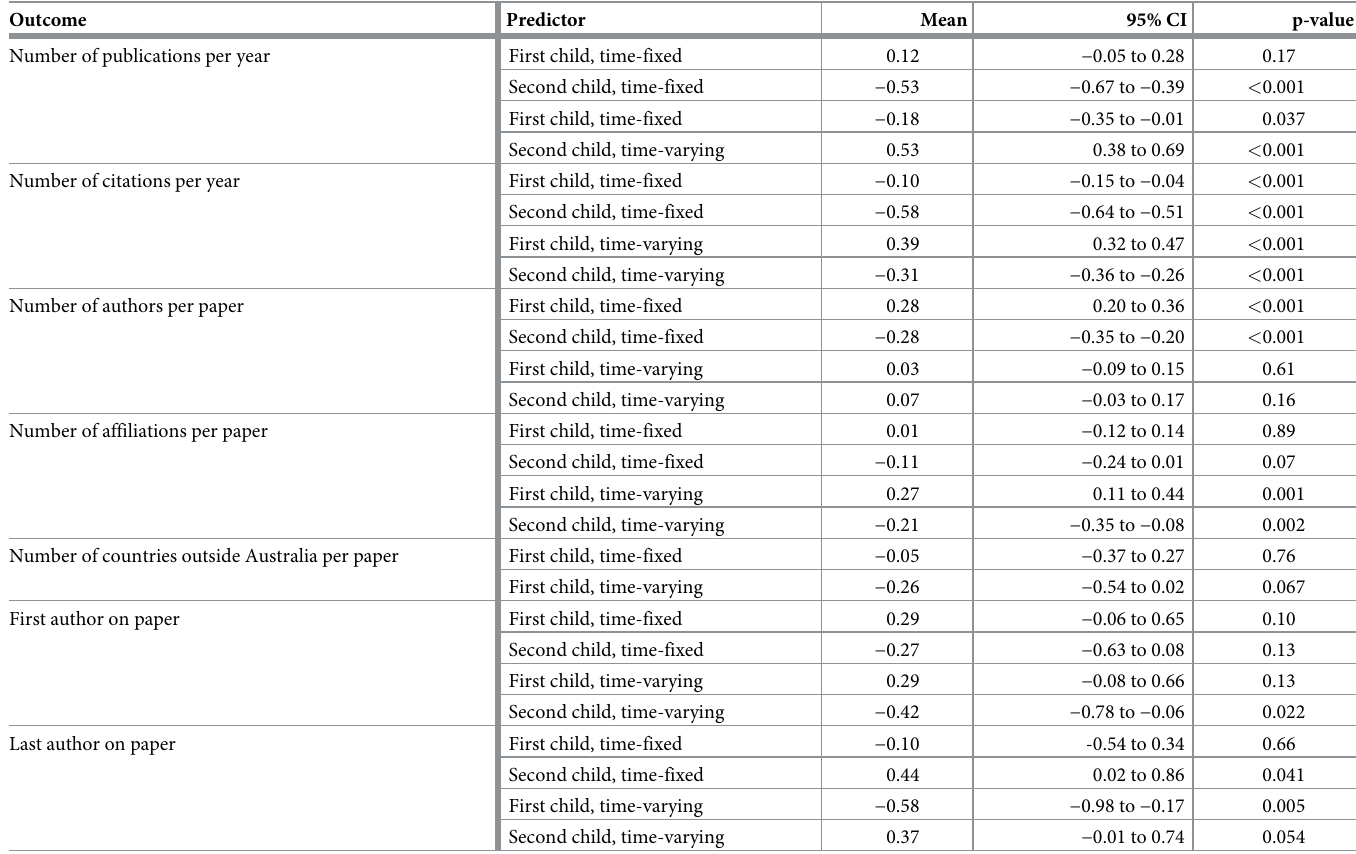
Table 3. Estimated means and 95% confidence intervals from a longitudinal regression model with predictors for two children. Results on a log-scale for the numbers outcomes and log odds scale for the two author order outcomes. The best model for the probability of being last author only included the first